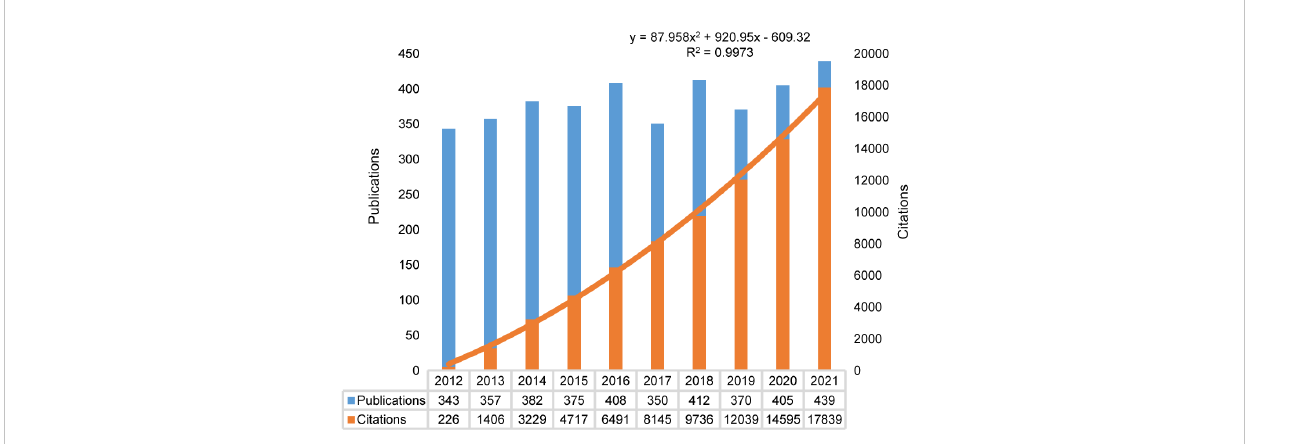
FIGURE 2 Annual trend of publications and citations. The orange line showed a regression model to illustrate citations per year (2012-2021). A total of 319 publications and 13576 citations were identi fi ed from January to November 2022.